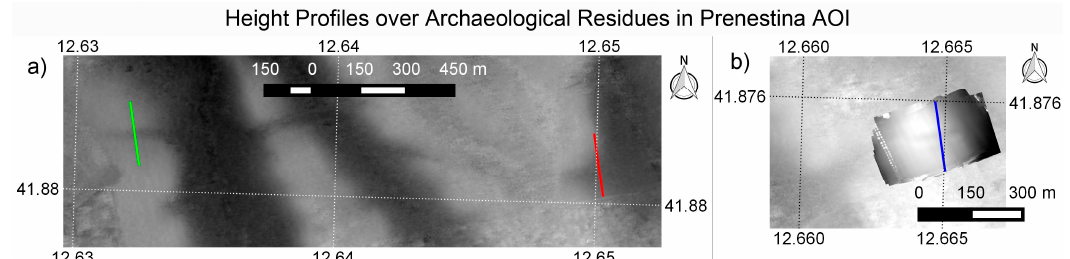
Figure 38. Profiles over residues in Prenestina AOI. Height measurements along the profiles in the various DEMs are plotted in Figure 43. ( a ) Profiles (in green and red) over residues of Road 384 overlain on SBAS DEM produced from CSK Spotlight time series. COSMO SkyMed data provided by the Italian Space Agnecy; ( b ) Profile (in blue) of residue of Road 497 overlain on DEM derived from UAV photogrammetry.